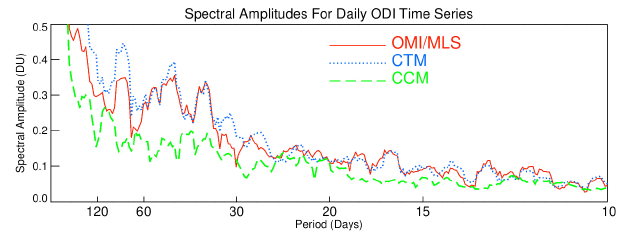
Figure 5. This figure plots calculated spectral amplitudes (in DU) of ODI derived from OMI (solid red curve), CTM (dotted blue curve), and CCM (dashed green curve) as functions of frequency (periods in days shown). Spectral amplitude is defined as the square root of c(ω) 2 + s(ω) 2 , where c and s denote Fourier cosine and sine coefficients, ω is frequency and the over-bar denotes application of a smoothed spectral estimator (see Appendix A for details of these calculations).